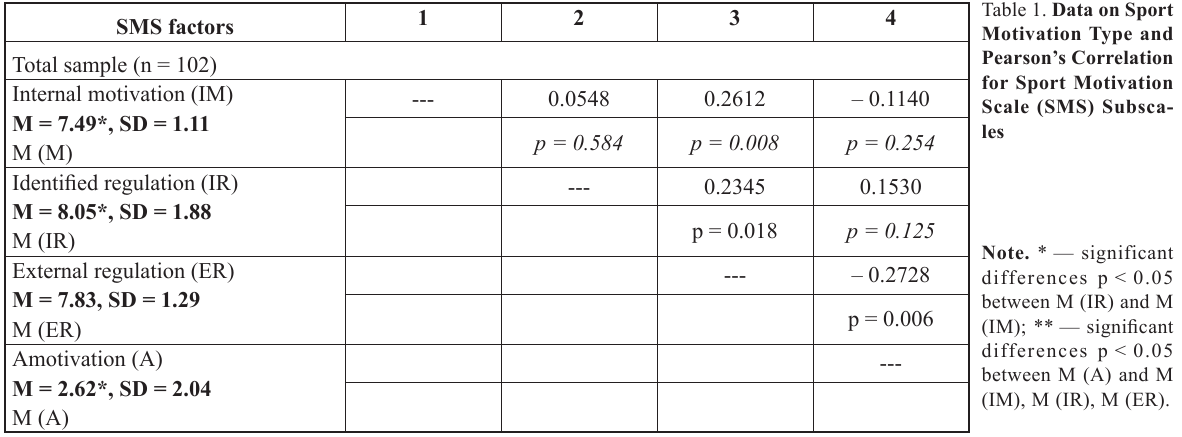
Table 1. Data on Sport Motivation Type